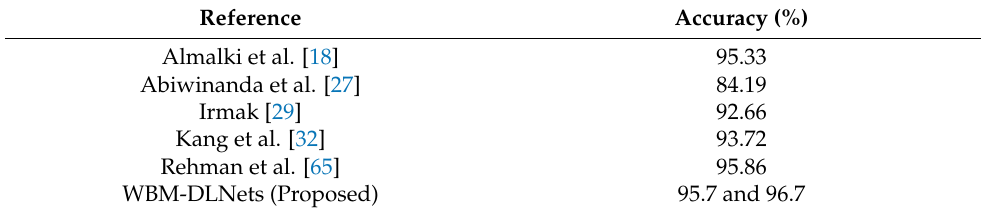
Table 6. Comparison of the proposed WBM-DLNets with other